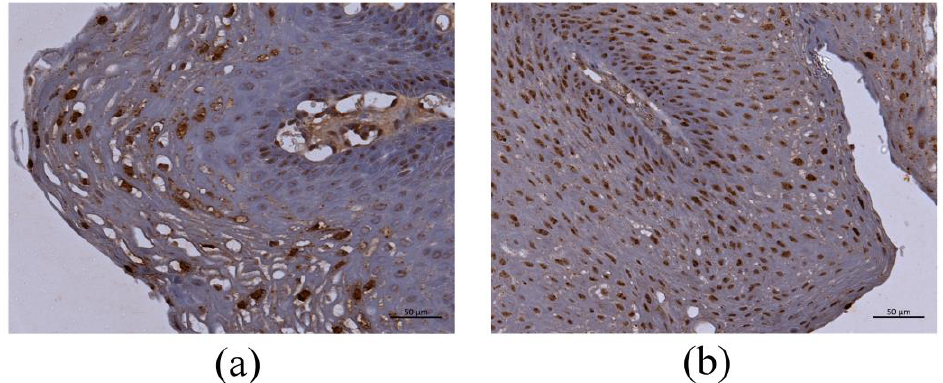
Figure 2. HPV-6-positive cells in LP by DNA-ISH. ( a ) The basal cells and middle to upper third layers of LP showed a positive reaction. Bar = 50 μm. ( b ) The positive reaction was observed in all LP layers. Bar = 50 μm.